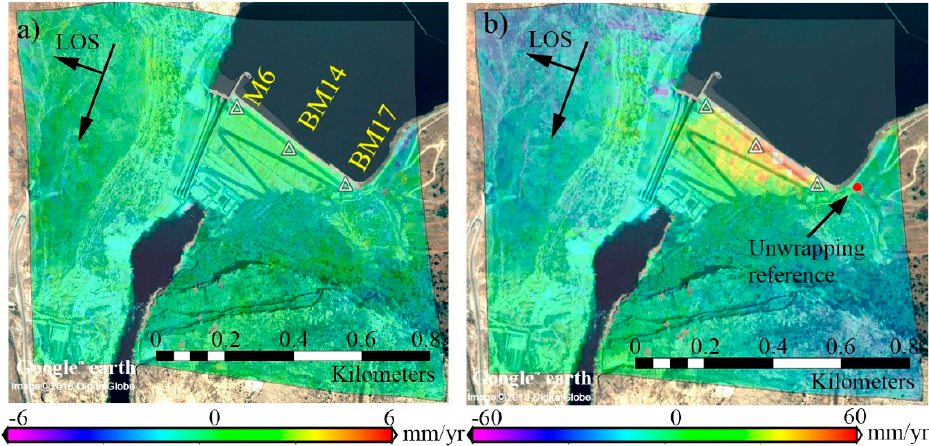
Figure 5. ( a ) The mean linear velocity estimated from Sentinel-1A/B before the earthquake event, during the period from 30 October 2014 to 7 November 2017, ( b ) the mean linear velocity after the earthquake, during the period from 19 November 2017 to 7 March 2018. Note that (i) the earthquake occurred on 12 November 2017 at 18:18 UTC, (ii) the reference point for phase unwrapping is indicated by the red dot in the abutment southeast of the dam, and (iii) positive implies that the Earth’s surface moved away from the radar sensor (i.e., subsidence in the radar line of sight), and negative implies uplift in the radar LOS.